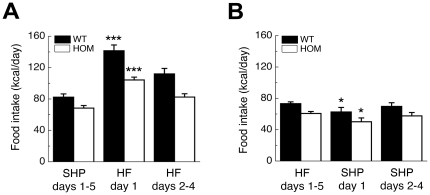
Acute hyperphagia in pmch
−/− rats when newly presented with HF diet.(A) Adult pmch
+/+ and pmch
−/− rats grown on standard SHP diet showed acute hyperphagia when newly presented with HF diet. However, acute hyperphagia was attenuated in pmch
−/− rats (172±6% increase in pmch
+/+ rats compared to 152±6% increase in pmch
−/− rats; ***P<0.001 versus SHP days1–5, repeated-measures ANOVA with special contrast analysis; n = 7–8 per group). (B) Adult pmch
+/+ and pmch
−/− rats grown on HF diet showed acute hypophagia when newly presented with SHP diet. Acute hypophagia was equal between genotypes (14±8% decrease in pmch
+/+ rats as compared to 17±7% decrease in pmch
−/− rats; *P<0.05 versus HF days1–5, repeated-measures ANOVA with special contrast analysis; n = 6–8 per group). Data are shown as mean ± S.E.M.